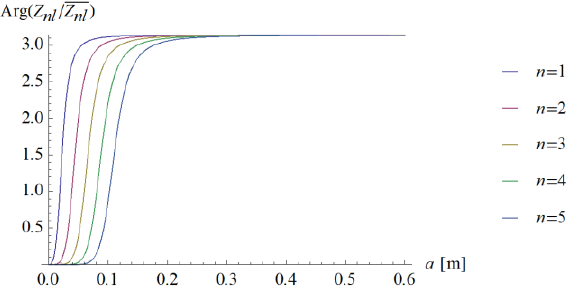
Figure 2. The phase of the term 𝑍 𝑛𝑙 /𝑍 𝑛𝑙 ̅̅̅̅ is plotted against the sphere radius 𝑎 . The frequency is 297.2 MHz; the sphere dielectric properties are: 𝜀 = 50𝜀 0 ,𝜎 = 0; the corresponding wavenumber 𝑘 = 44.89 m −1 .